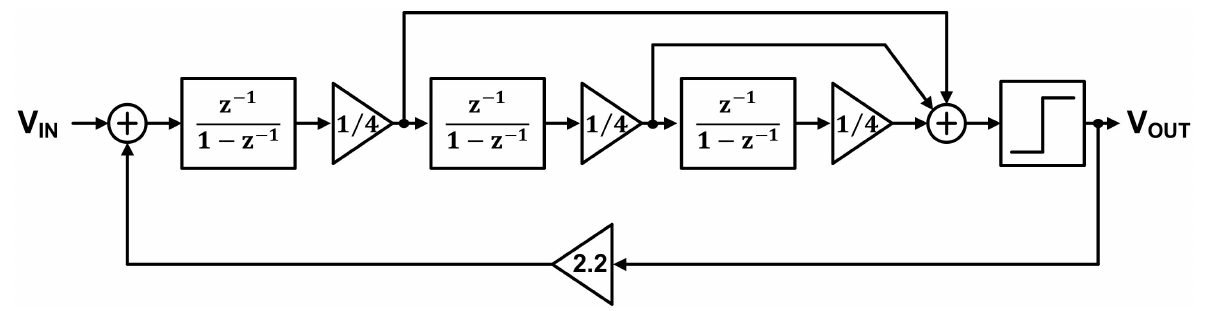
Figure 17. ADC block